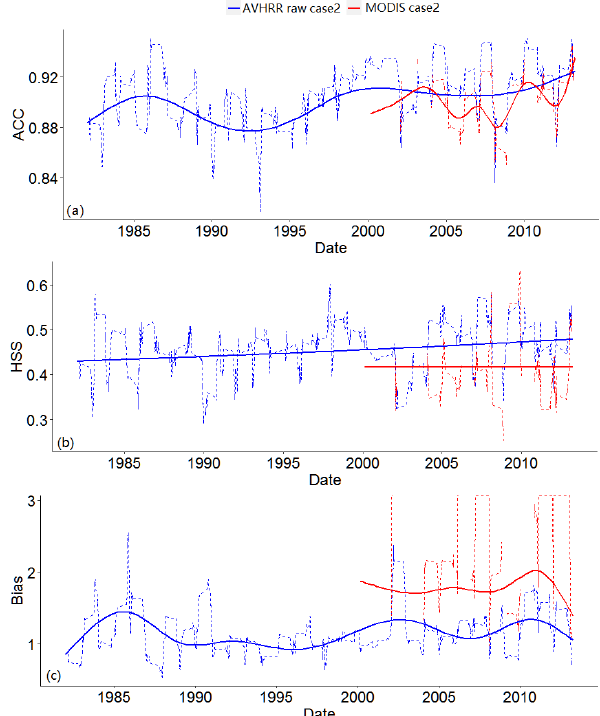
Figure 4. The time series (denoted by the dashed lines) of ACC, HSS, and Bias for AVHRR raw and MODIS snow data during the investigated period. A simple moving average with a box dimension of n = 30 was applied to the time series in order to reduce the noise and uncover patterns in the data. The solid lines represent the fitted trend of these accuracy